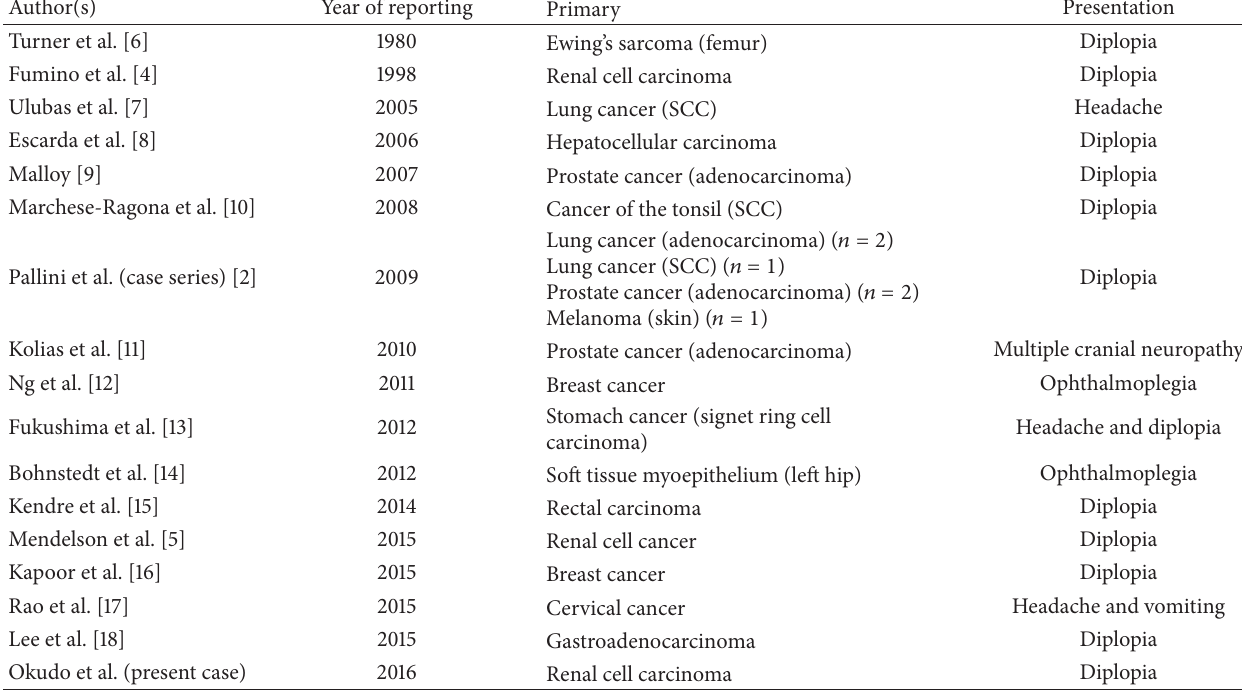
Table 2: Cases of clival metastasis available from PubMed (and other databases) along with the primary and